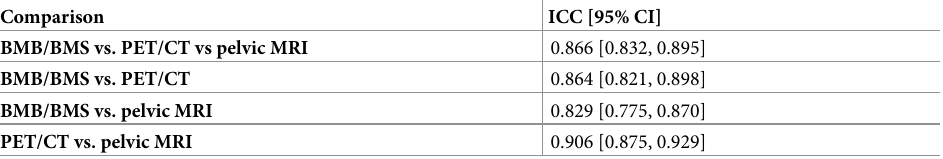
Table 3. Intermethod agreement.